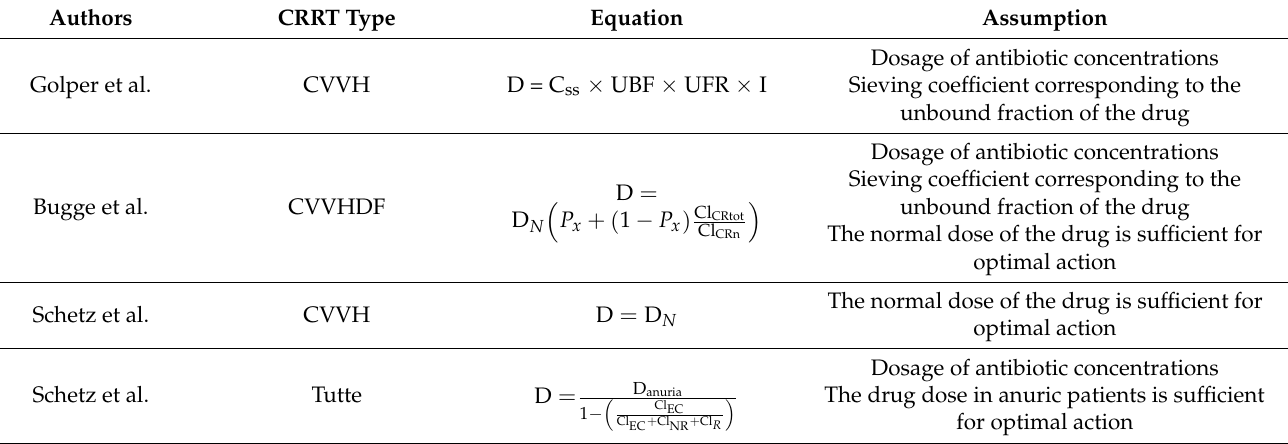
Table 5. Methods for estimating antibiotic dosage in CRRT